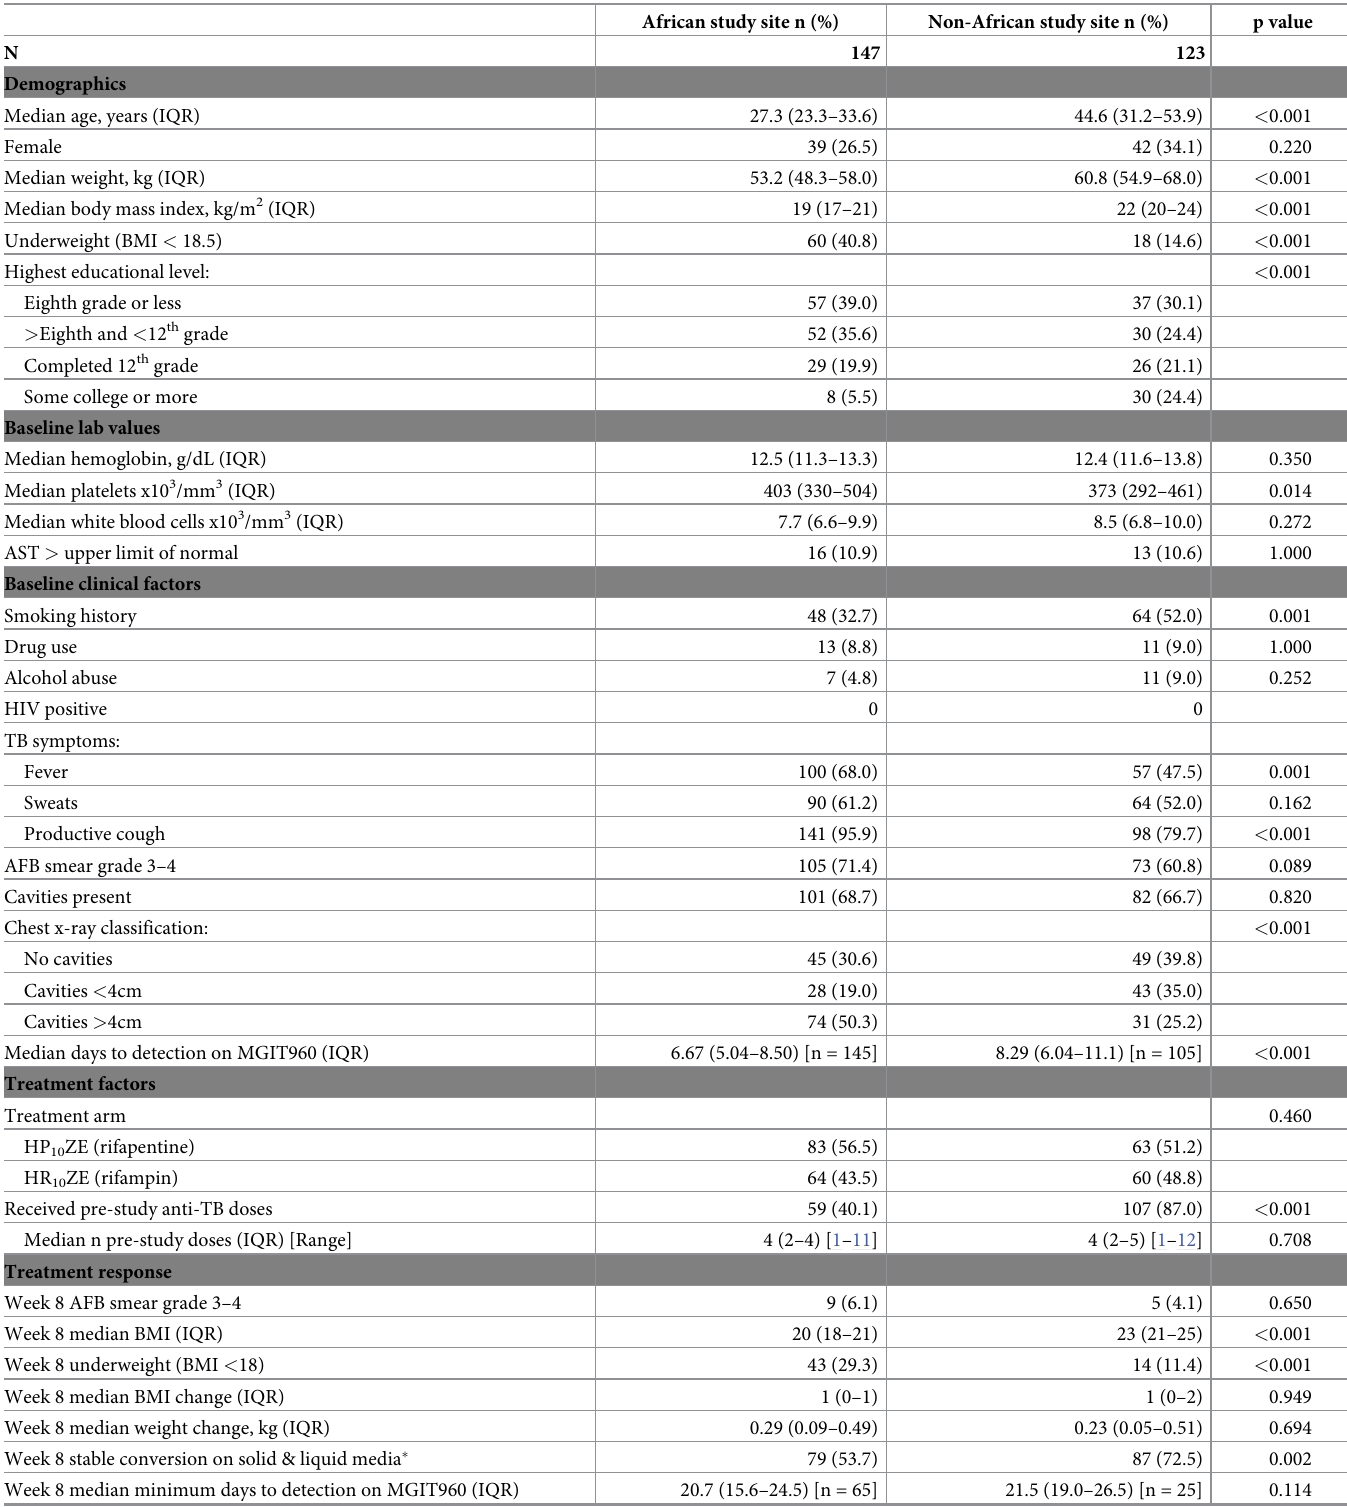
Table 1. Participant characteristics by study